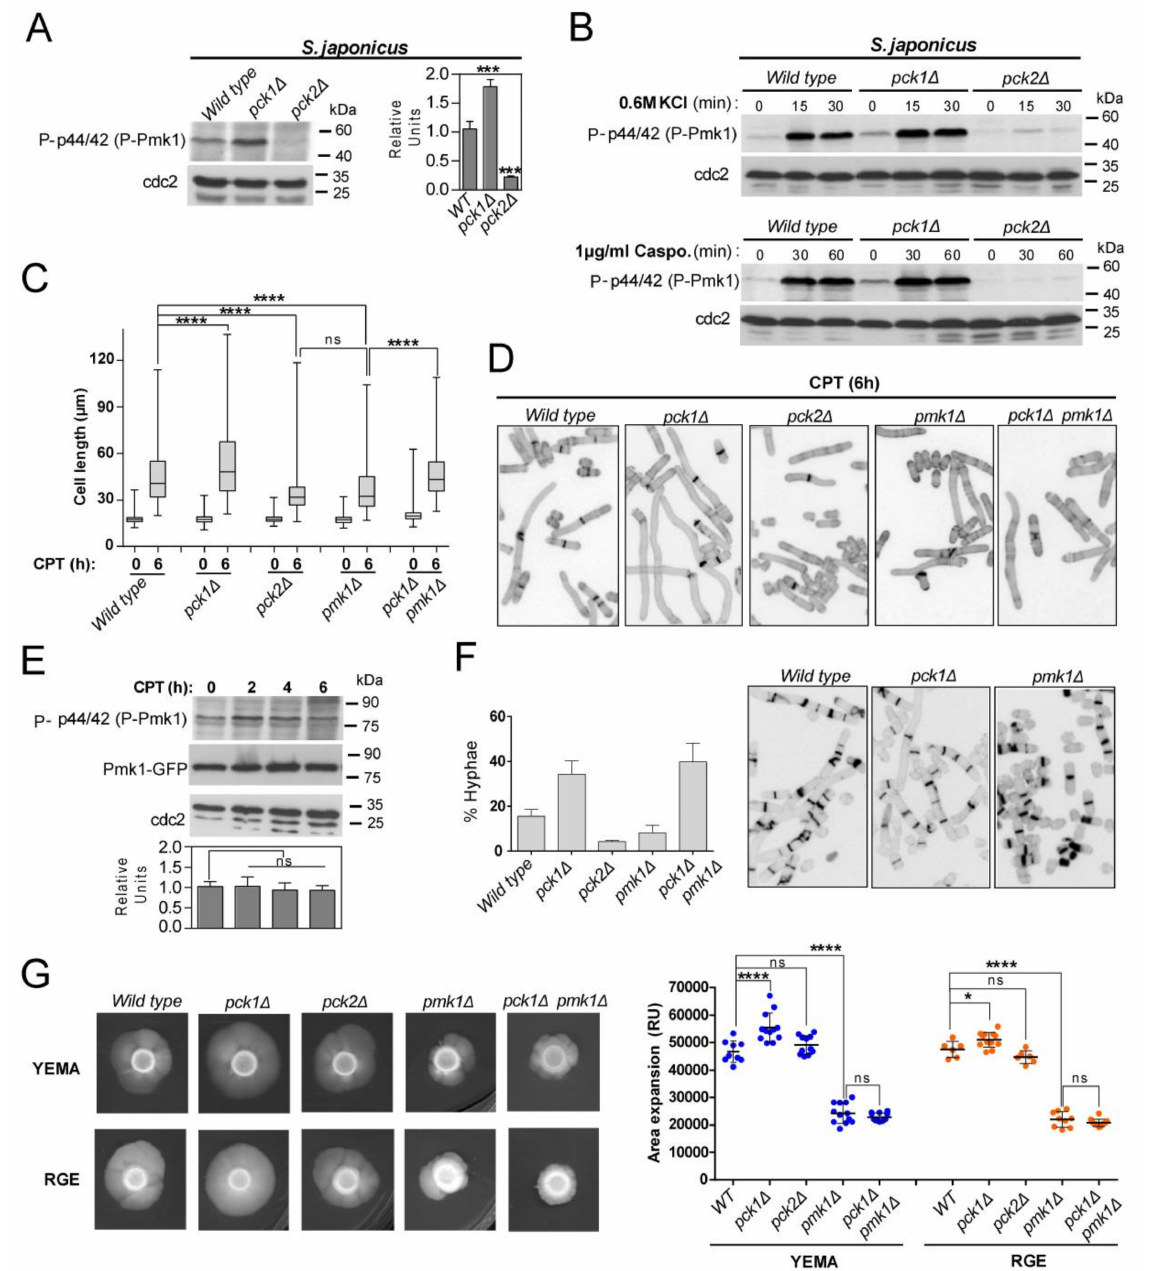
Figure 2. Antagonistic control of Pmk1 activity by PKC orthologs Pck1 and Pck2 modulates S. japonicus hyphal differentia- tion. ( A ) S. japonicus strains of the indicated genotypes were grown in YES medium to mid-log phase, and activated Pmk1 were detected with anti-phospho-p44/42, whereas anti-Cdc2 was used as a loading control. Relative units as mean ± SD (biological triplicates) for Pmk1 phosphorylation (anti-phospho-p44/42 blot) were determined with respect to the